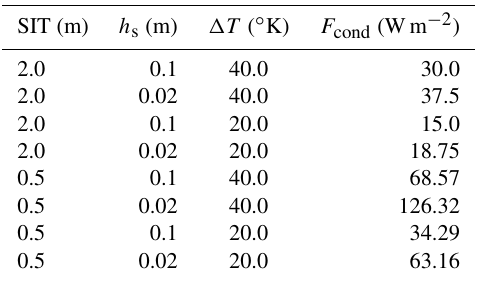
Table 1. Conductive heat fluxes ( F cond ) calculated with Eq. (2) for example sea ice thicknesses (SIT), snow thicknesses ( h s ) , and tem- perature gradients ( (cid:49)T